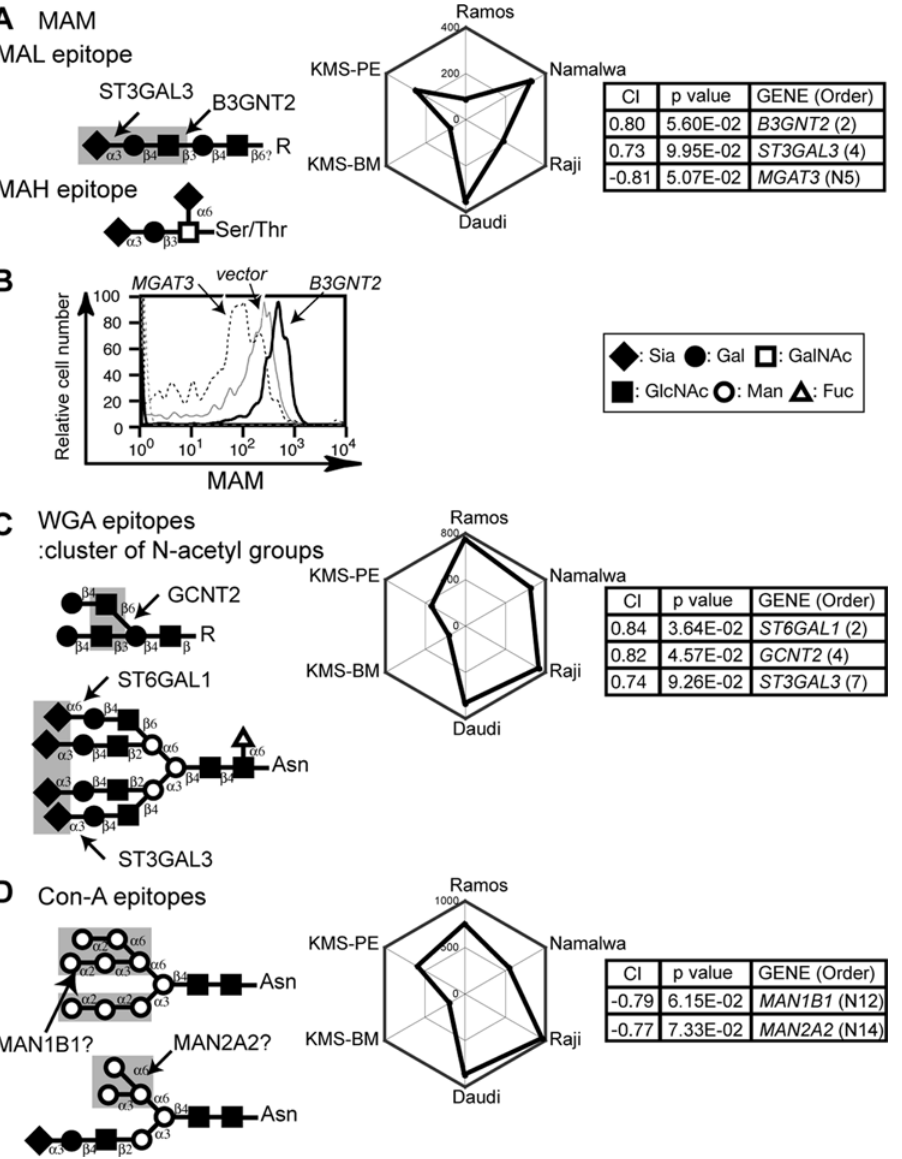
Figure 5. CIRES analyses of staining profiles obtained using lectins that recognize multiple glycan structures and have unknown epitope expression-regulating enzymes. Presentation is the same as in Fig. 2 except that the plant lectins used were (A–B) MAM, (C) WGA, and (D) Con-A. The epitopes of the two different lectins of MAM, MAL and MAH, are illustrated separately. WGA essentially recognizes a cluster of N-acetyl groups, as indicated, and thus required Neu5Ac as a Sia species. Con-A recognizes mannose-containing glycans with varying affinities. High-mannose-type glycans (upper diagram in (D) ) bind best to this lectin. (B) Namalwa cells were infected with retroviruses encoding various GlcNAc transferases. The MAM staining patterns of the EGFP-positive populations of each infectant are shown. MGAT5 overexpression did not shift the staining pattern in comparison with the vector control (data not shown).